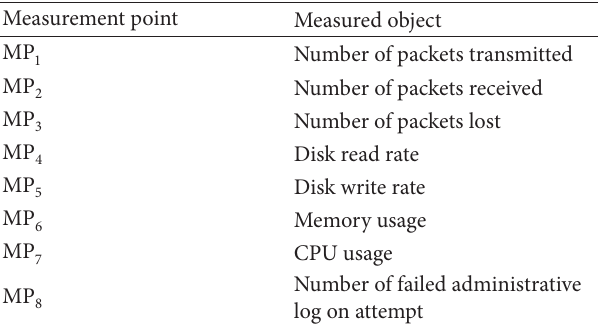
Table 1: Virtual machine behavior metric